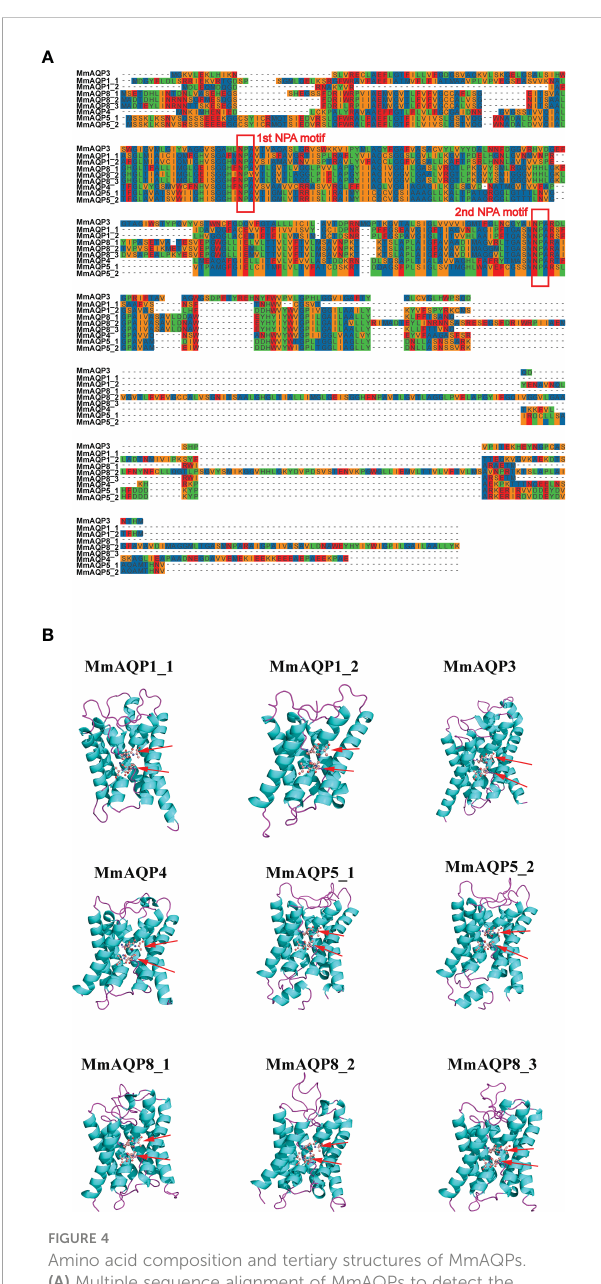
FIGURE 4 Amino acid composition and tertiary structures of MmAQPs. (A) Multiple sequence alignment of MmAQPs to detect the conserved NPA motifs. The two NPA motifs in each MmAQP are marked with red rectangles. (B) Homology modelling of the 3D structures of MmAQPs. Six transmembrane a -helices in each MmAQP are labeled with cyan, and the linker loops are labeled with purple. The NPA motifs are marked with red